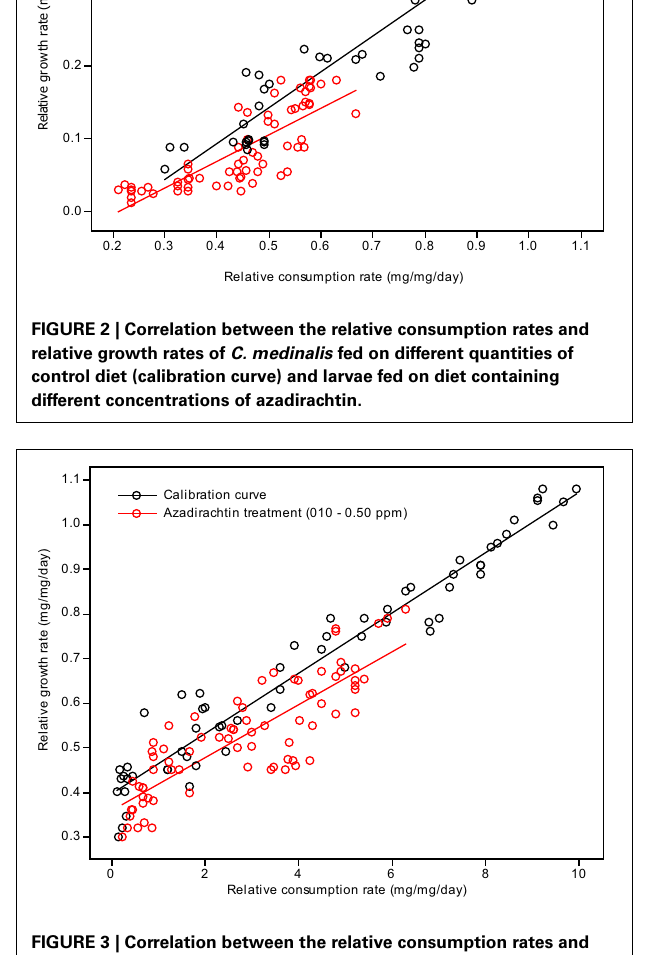
FIGURE 3 | Correlation between the relative consumption rates and relative growth rates of S. litura fed on different quantities of control diet (calibration curve) and larvae fed on diet containing different concentrations of